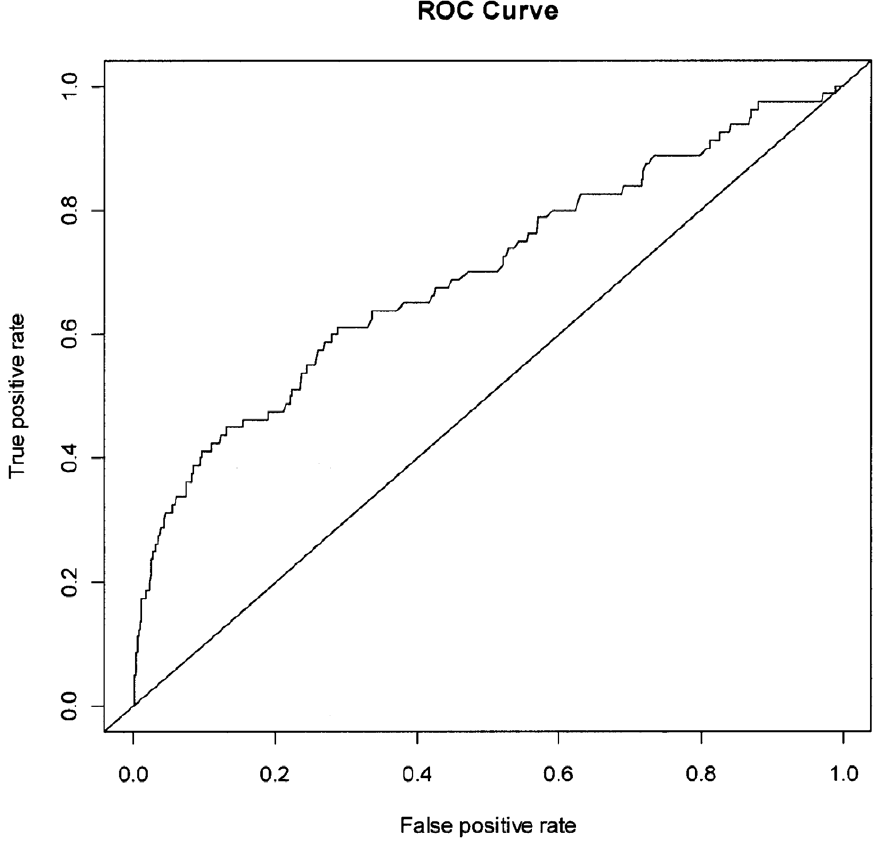
Figure 2. Receiver-operating characteristic curve for SPTB-IM.